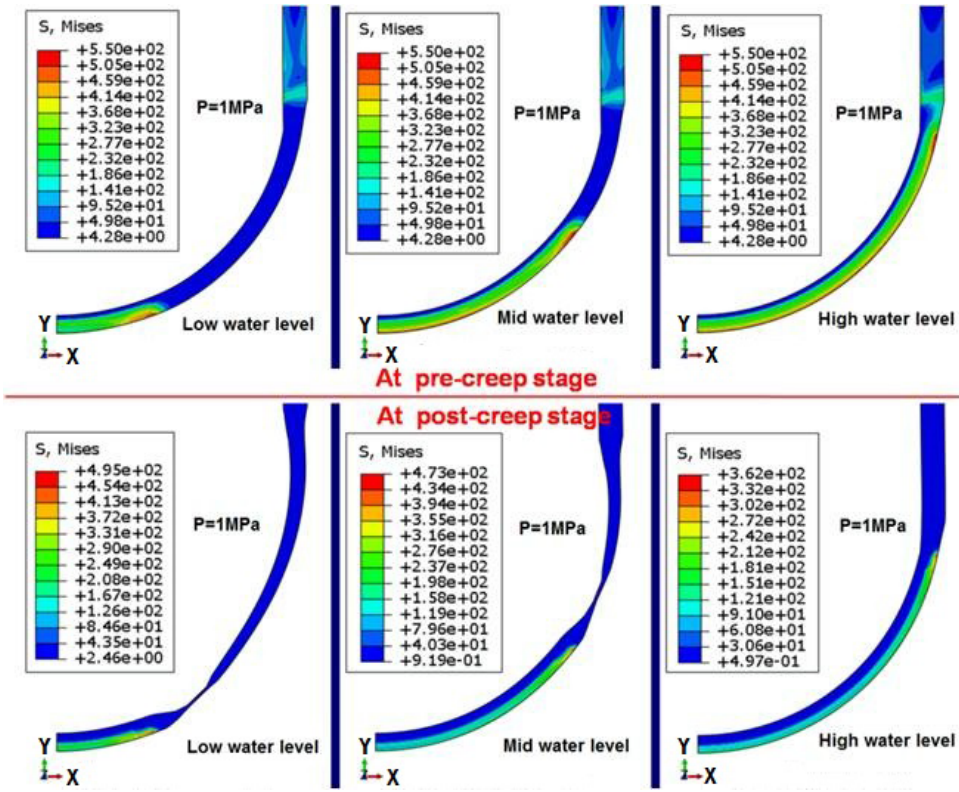
Figure 4. Mises stress contours for RPVs with various water levels at pre- and post-creep stages.